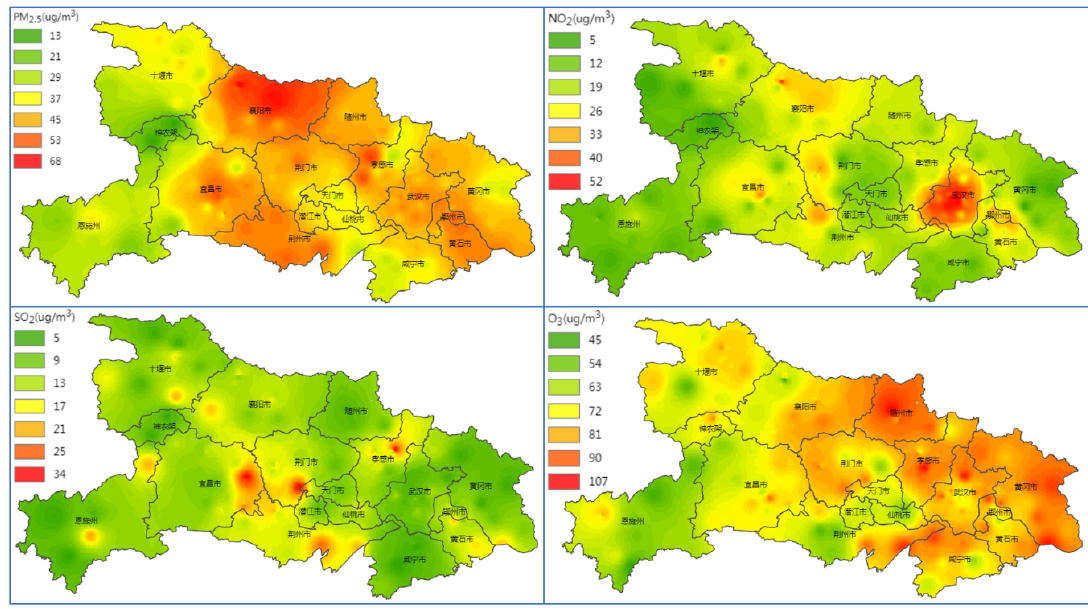
Figure 14. Annual mean of interpolated PM 2.5 , SO 2 , NO 2 , and O 3 values from ambient monitoring stations with the Kriging method in Hubei during 2017.